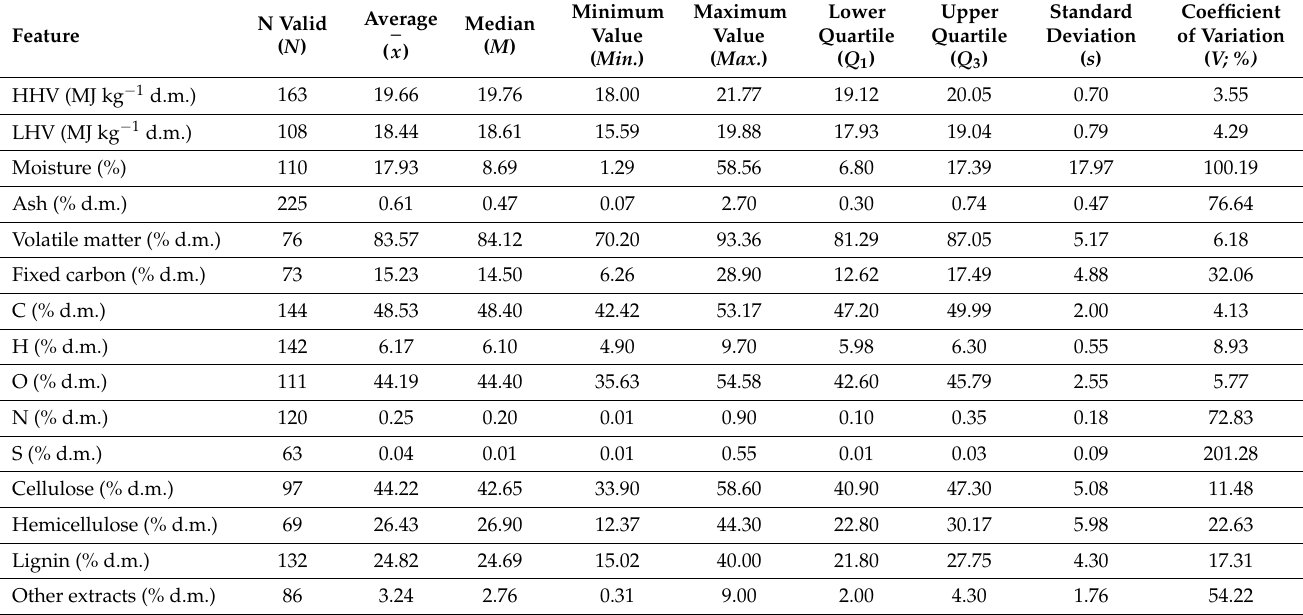
Table 1. Differentiation of the thermophysical properties and composition of wood without differen- tiation by type.